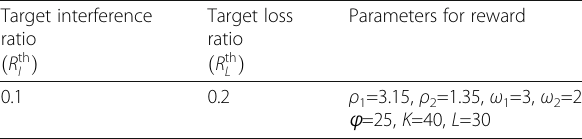
Table 3 Target value and experimental